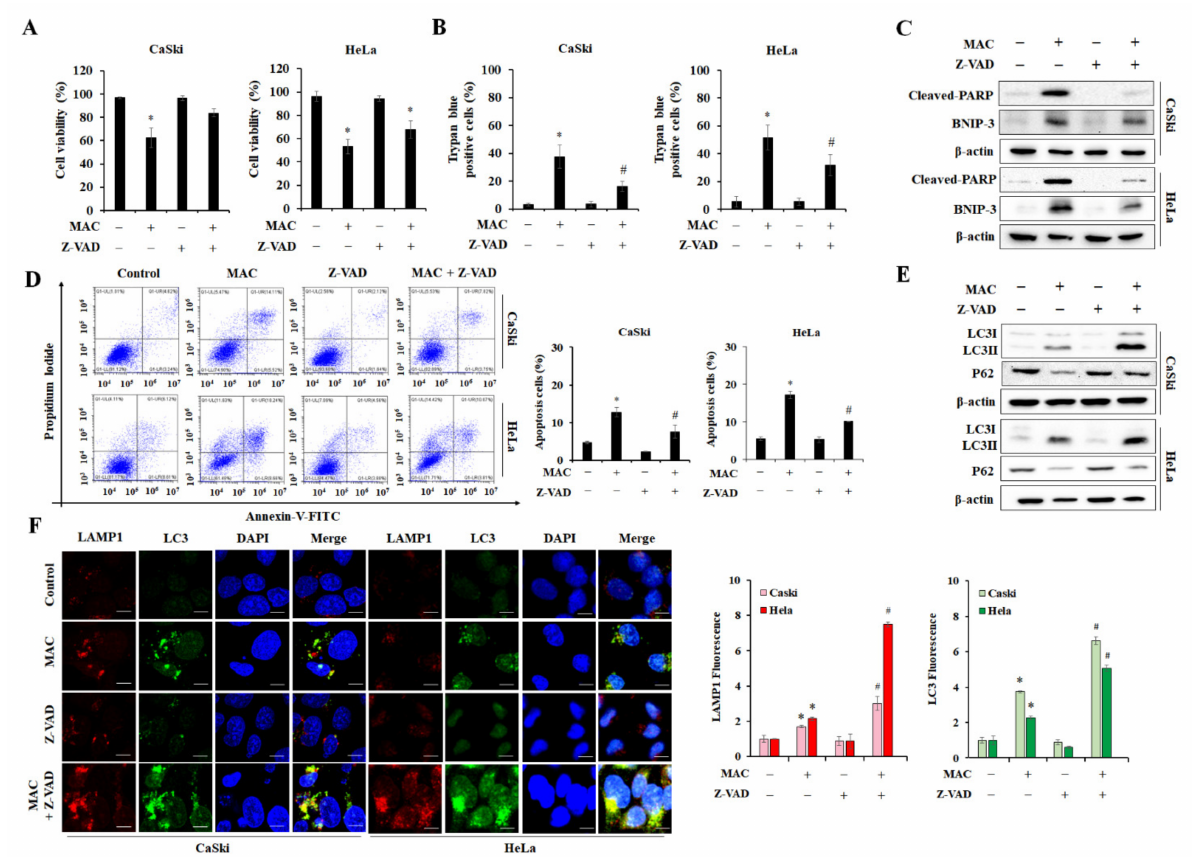
Figure 5. Inhibition of apoptosis enhances MAC-induced autophagy. ( A , B ) Cells were stained with trypan blue for detection of dead cells treated with MAC (20 µ M) with or without Z-VAD-FMK (10 µ M). ( C ) The protein levels of BNIP-3 and Cleaved-PARP were assessed with Western blotting analysis of CaSki and HeLa cells treated with or without MAC and Z-VAD-FMK, respectively. ( D ) Cells were labelled with annexin V-FITC/PI to detect the apoptotic cells. ( E ) The protein levels of LC3 and p62 were assessed with Western blotting analysis of CaSki and HeLa cells treated with or without MAC and Z-VAD-FMK, respectively. ( F ) Cells were treated with drugs for 24 h and then subjected to immunofluorescence analysis using LC3-antibody (green) and LAMP1 (red). All nuclei were stained using DAPI (blue). The intensity of LC3 and LAMP1 puncta was measured by ImageJ program. Scale bars were 10 µ m. Data represent the mean ± SD of three independent experiments. * p < 0.05 vs. negative control and # p < 0.05 vs. MAC. Results were analyzed using one-way ANOVA followed by Bonferroni post hoc